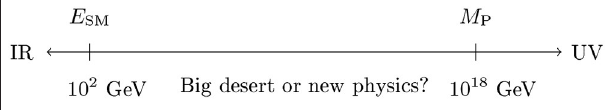
FIGURE 4 | Different energy scales. Is there new physics beyond the EW scale and the Planck scale or a “big desert”? description is not known a priori. Assuming no new physics at scales in between the electroweak (EW) scale of the standard model (SM) of particle physics and the scale at which gravity becomes comparable to the other interactions (see Figure 4 ), the Planck scale might be the natural cutoff scale, M